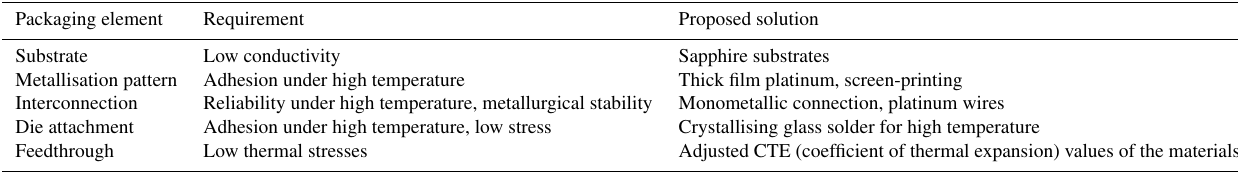
Table 1. Challenges and possible solutions to the presented high-temperature assembly technology. Packaging element